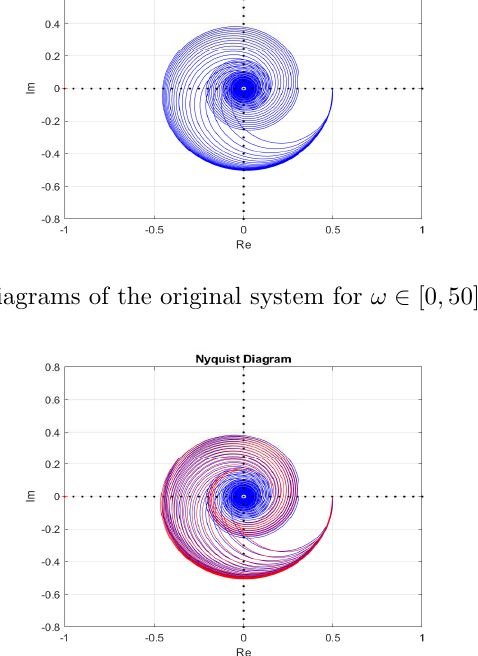
Figure 4. Nyquist diagram of the original system (blue) and the first order approximation (red) for ω [0 , 50] and h = 0 . 1 : 0 . 1 : 2. ∈